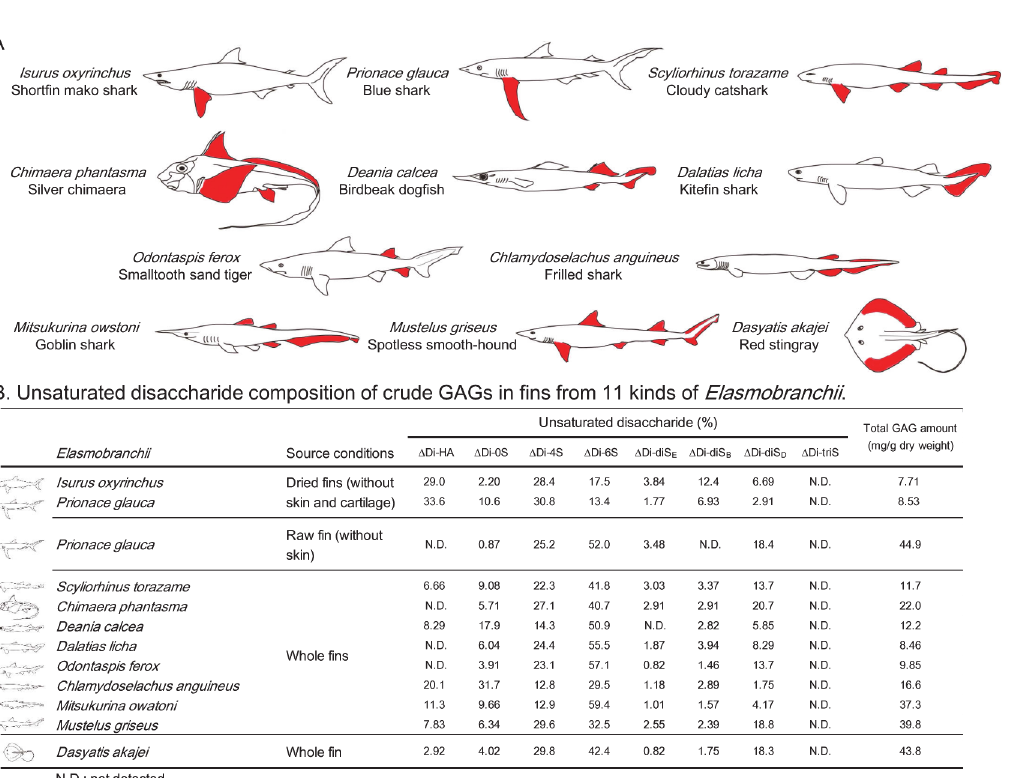
Fig 1. GAG components from various kinds of Elasmobranchii . (A) Depiction of 11 kinds of Elasmobranchii . Position of fin samples used in this study are shown in red. (B) Determination of disaccharide compositions of GAGs. Purification and unsaturated disaccharide analysis were performed as described under “ Materials and Methods ” . Unsaturated disaccharide analysis was repeated twice with reproducible results.